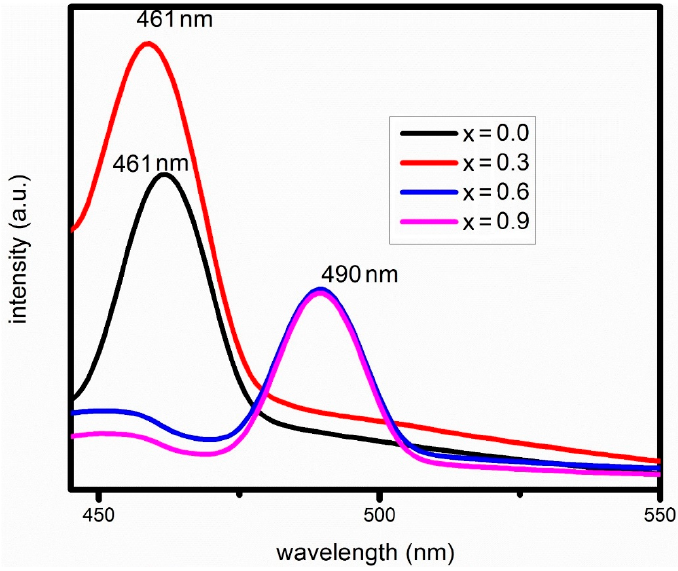
Figure 8. PL spectra of Cu-doped cobalt ferrite (Co 1 − x Cu x Fe 2 O 4 ) nanoparticles with (x = 0.0, 0.3, 0.6, 0.9).